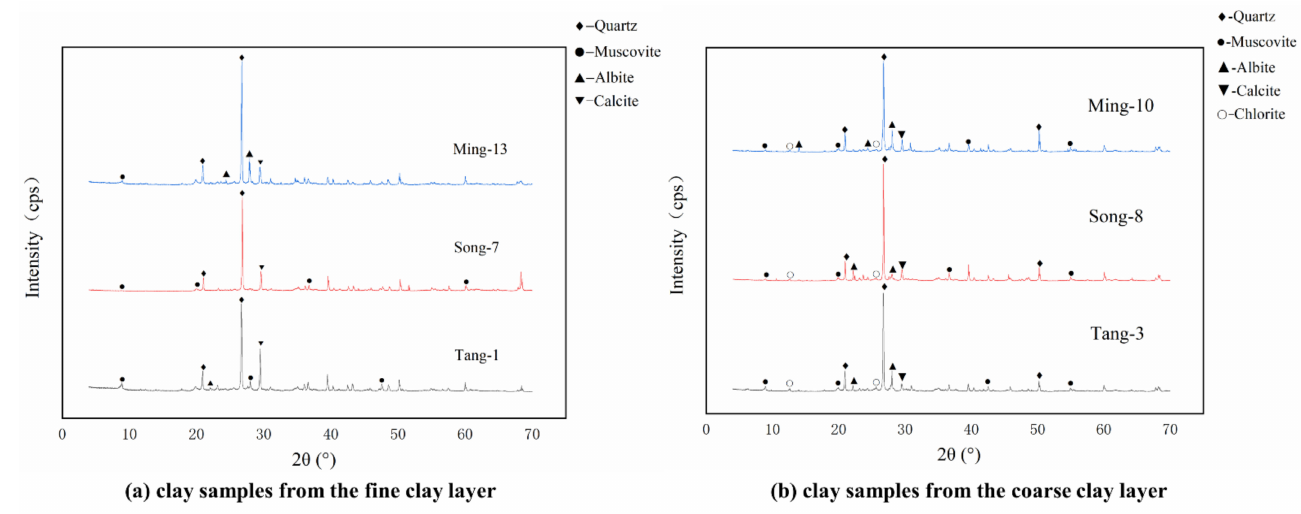
Figure 5. Mineral composition of coarse and fine clay by XRD: Tang-1 and 3 were collected from sculptures in XSBD (Tang dynasty); Song-7 and 8 were collected from sculptures in XSND (Song dynasty); Ming-10 and 13 were collected from sculptures in SFD (Ming dynasty).